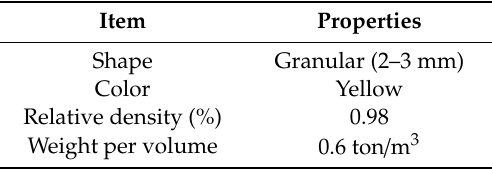
Table 3. Physical properties of tafpack super (TPS).